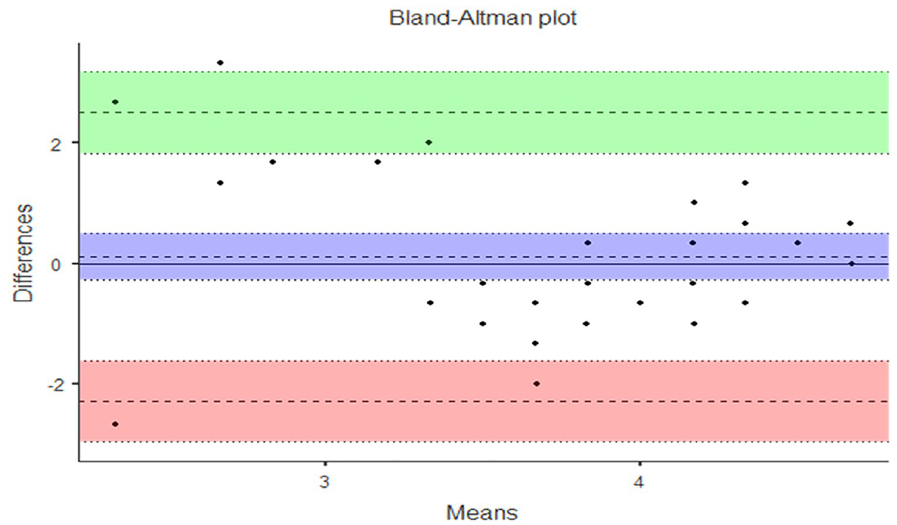
Fig 1. Differences in the evaluation of technical skills between the instructor and